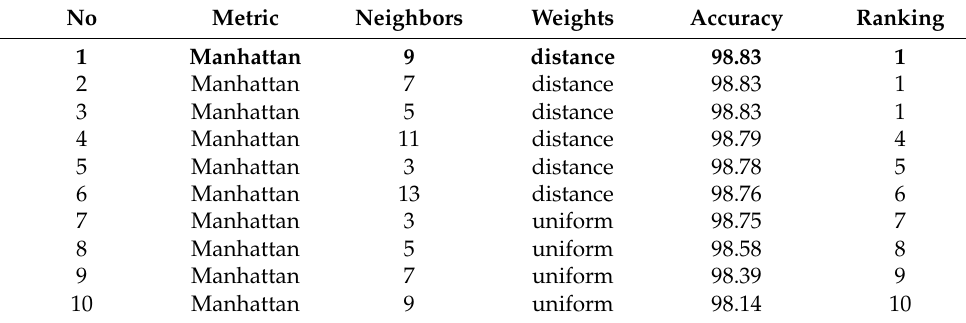
Table 9. K-nearest neighbors algorithm hyperparameter optimization